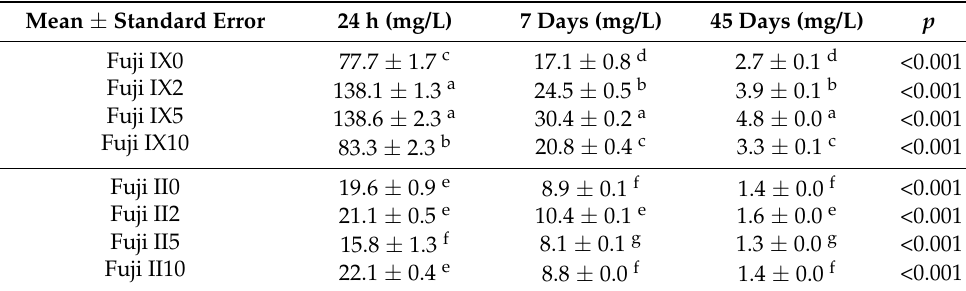
Table 3. The release rate of flouride after 24 h, 7 days, and 45 days. Mean ± Standard